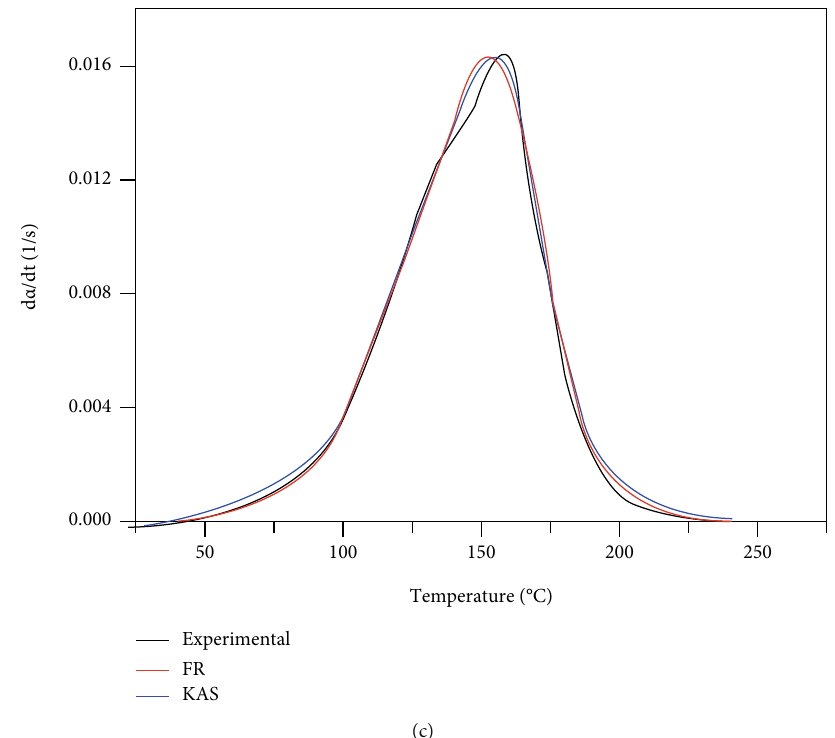
Figure 12: Comparison of experimental data with the kinetic models for (a) GEP, (b) GELP, and (c) GELNiP at heating rate of 5 ° C/min based on the Friedman and KAS